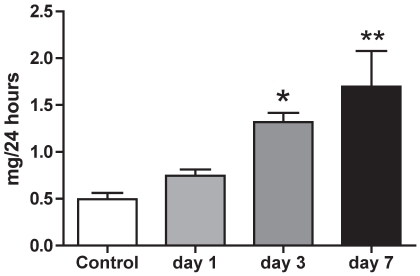
24-hour urinary excretion of albumin.Urine was collected from conscious cyp1a1-Ren2 transgenic rats (n = 8) maintained in individual metabolism cages, over consecutive days of transgene induction. Data are mean ± SE. Statistical comparisons were made using ANOVA with Bonferroni post-test. **P<0.01, *P<0.05 versus the control day.